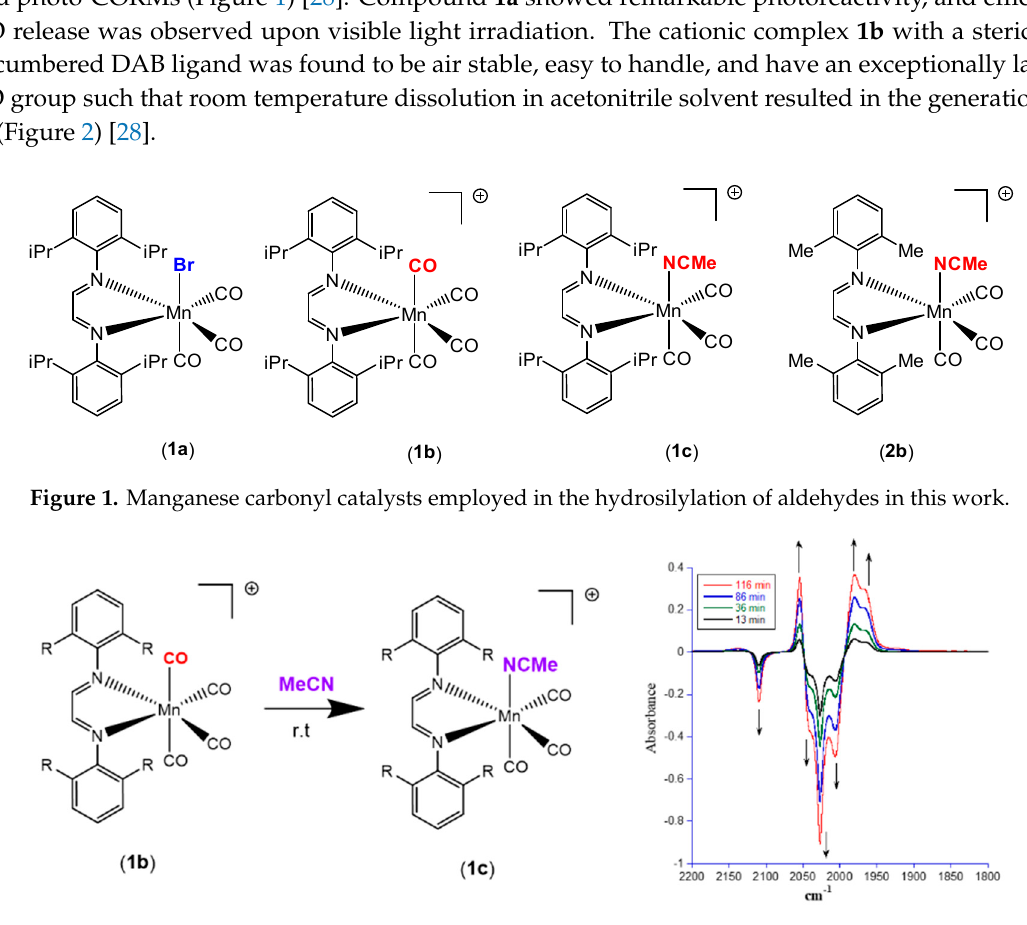
Figure 2. Facile substitution of a carbonyl ligand in 1b by acetonitrile at 298 K.